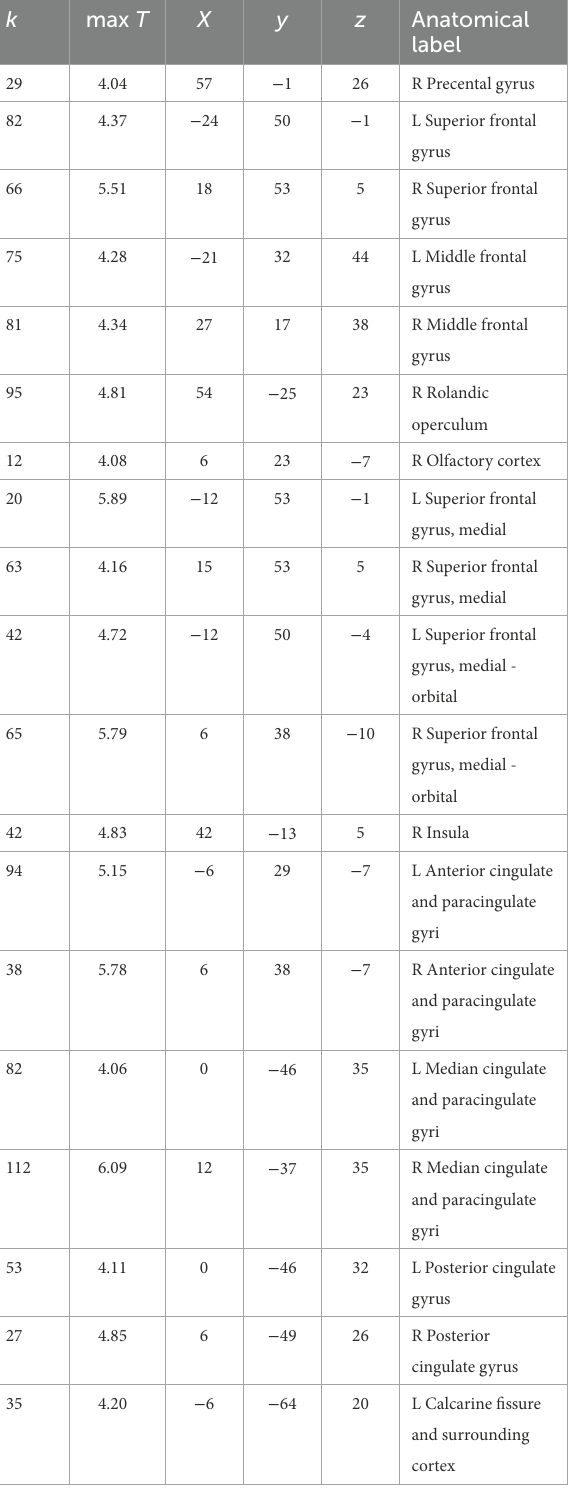
TABLE 1 Listing of anatomical structures with statistically significant group effect of reading words vs. reading nonwords after RT